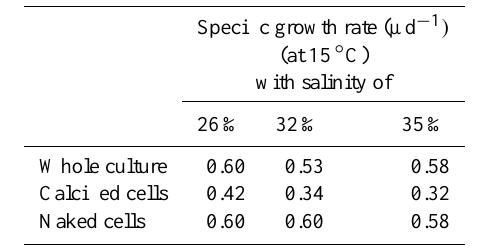
Table 2. Effect of salinity on growth rates of the coccolithophore E. huxleyi isolated from the Arctic Sea (MR70N). For other conditions, see Table